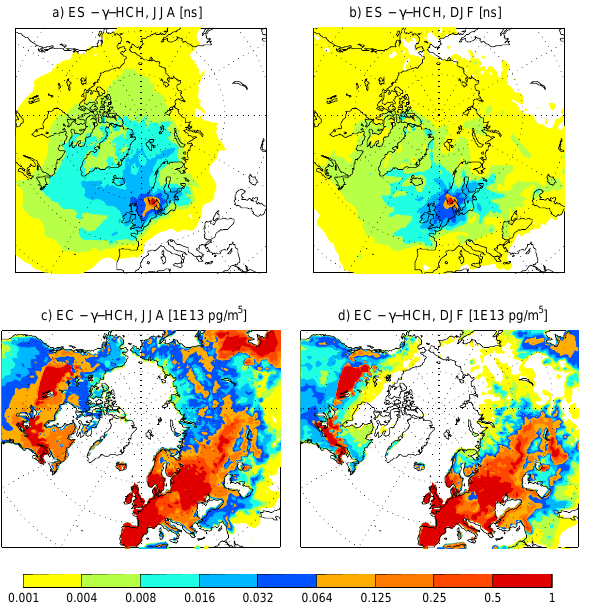
Fig. 12. Panel (a) shows the different regions for which relative source contributions for the Birkenes station (marked with a white circle) have been calculated (1, Western Europe ; 2, UK and Ireland; 3, Eastern Europe; 4, Central Europe; 5, Scandinavia; 6, America (denoted with A); 7, other countries (denoted with O)) Panels (b) and (c) show the regional source contributions (in % of the total) for simulated PCB-28 and γ -HCH, respectively, with the colors indicating the contributions from the different regions as colored in panel (a). The grey bars show the contributions when they are weighted by the ratio of the measured/modeled